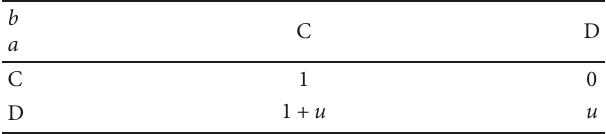
Table 2: Normalized payo ff s for agent a against agent b in a prisoner ’ s dilemma game; 0 < u < 1